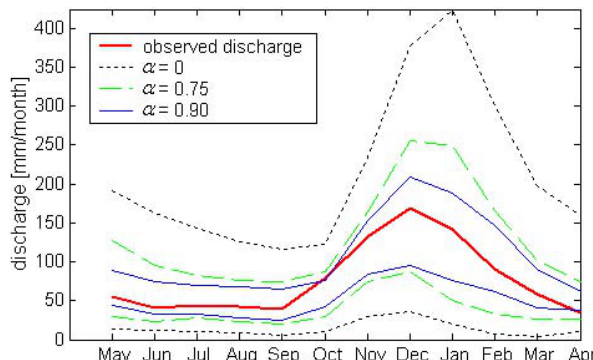
Fig. 8. Observed discharge and selected possibility bounds derived from the aggregate possibility distribution π agg 1 , 2 , 3 for the hydro- logical year 1983/1984.